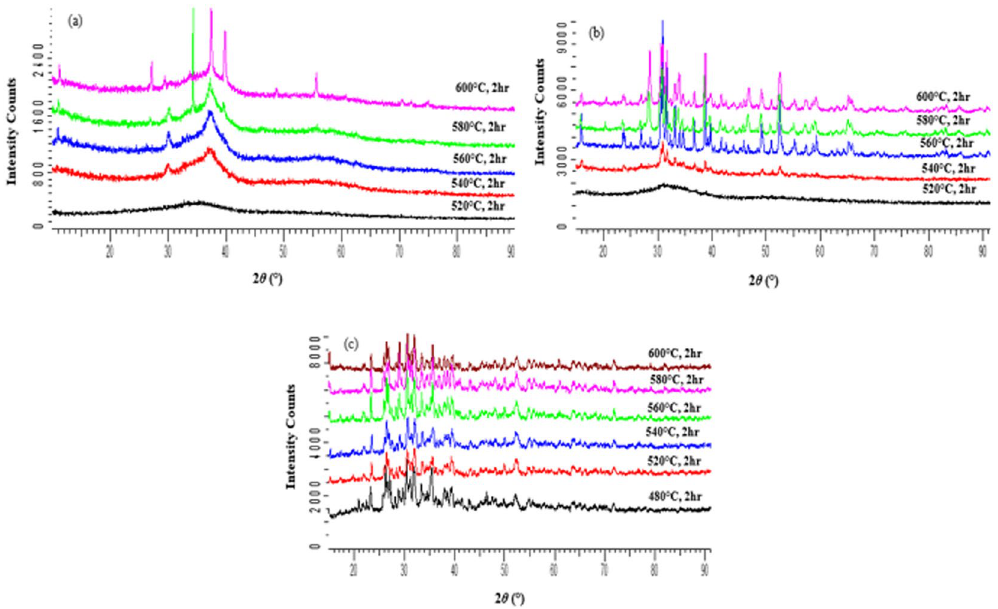
Figure 5. X-ray diffraction patterns of glass ( a ) S53B50 ( b ) P40B10 and ( c ) Sr as a function of